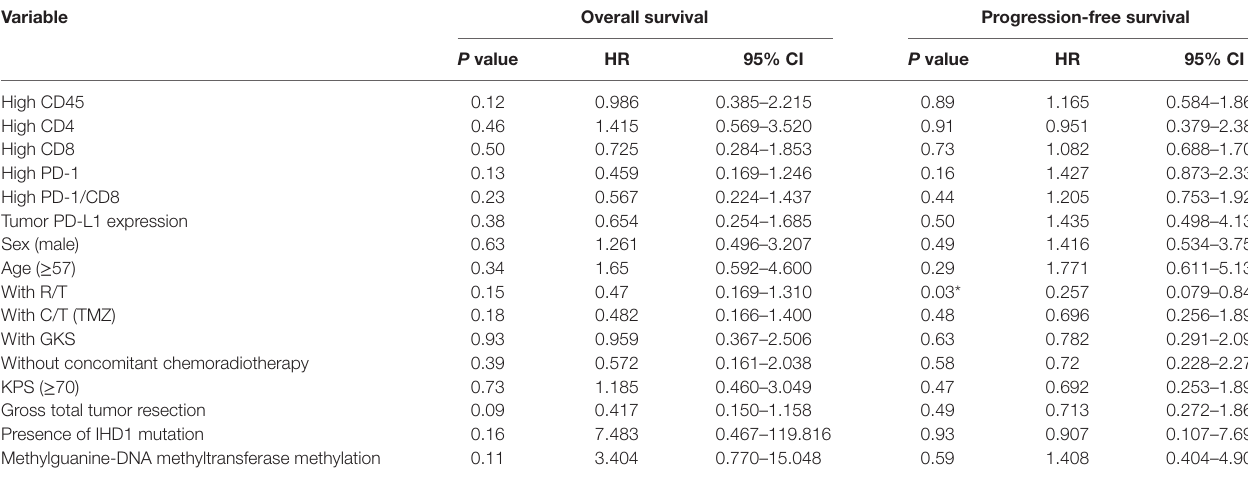
TaBle 6 | Multivariate analysis using a Cox proportional hazards model for overall and progression free survival in reference group patients. Variable